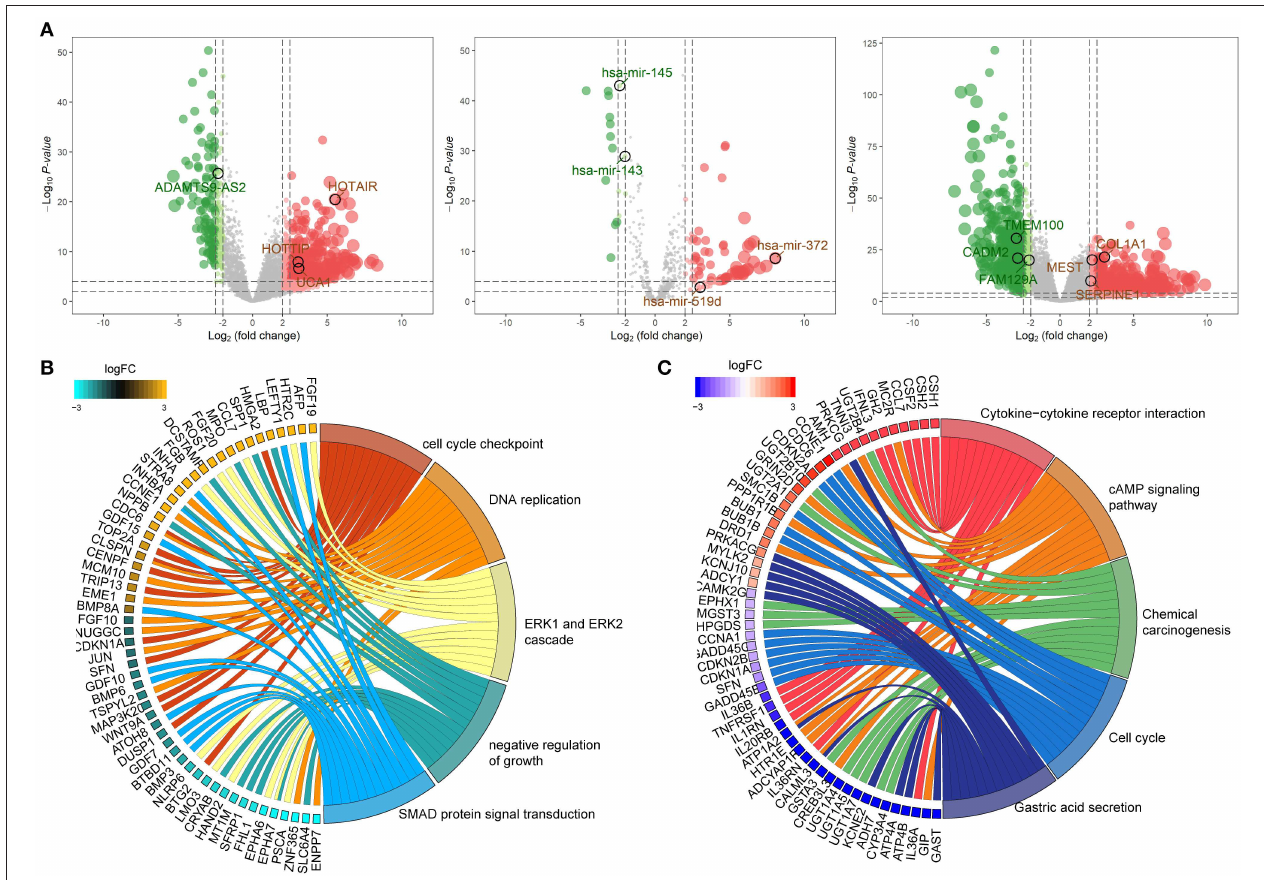
FIGURE 2 | Identification of differentially expressed RNAs and functional annotation of DEmRNA. (A) Volcano map of differentially expressed lncRNA (left), miRNA (middle), and mRNA (right). Red and green spots represent significant up- and down-regulated RNAs, respectively. (B) The top 5 significantly enriched GO biological process and relevant genes. (C) The top 5 significantly enriched KEGG pathways and relevant